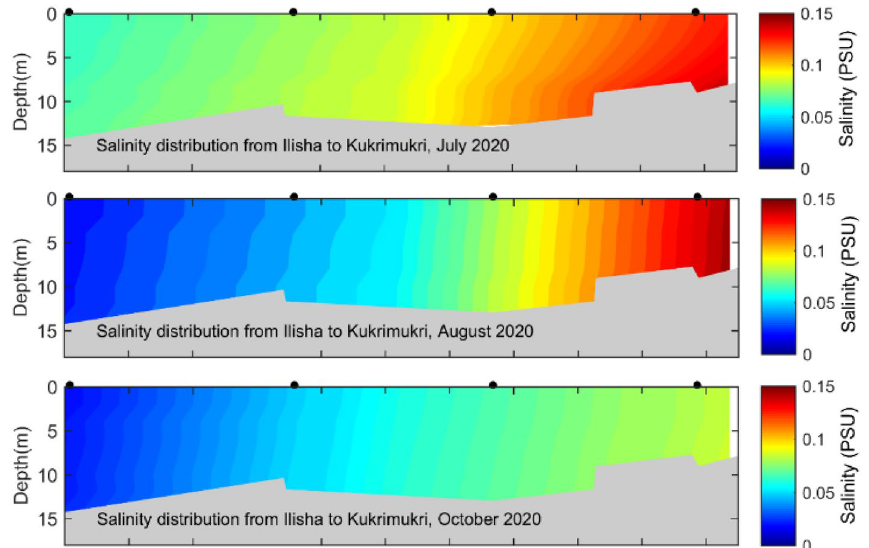
Figure 3. Vertical salinity distribution in the Lower Meghna River estuary during the wet (July, August and October) season in 2020 and